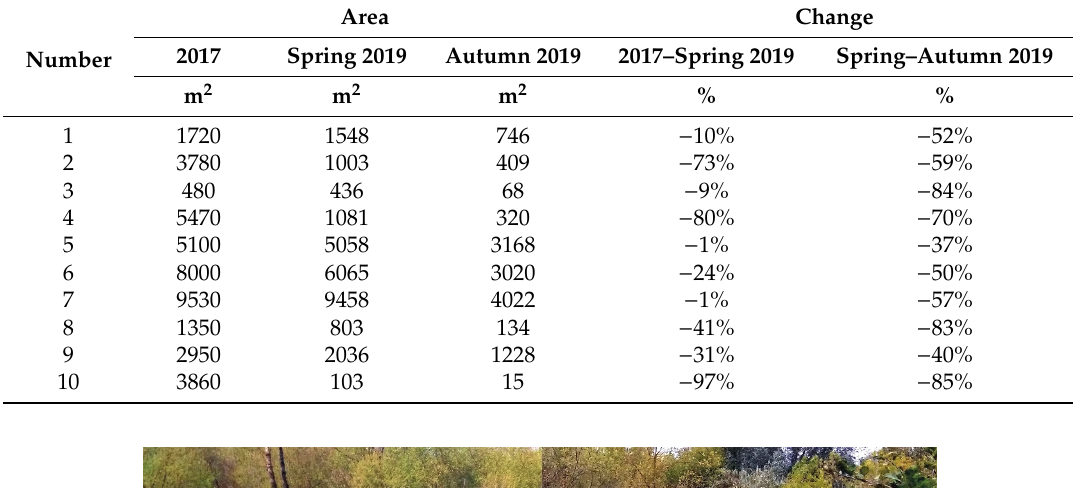
Table 3. Surface water area changes in the reservoirs.